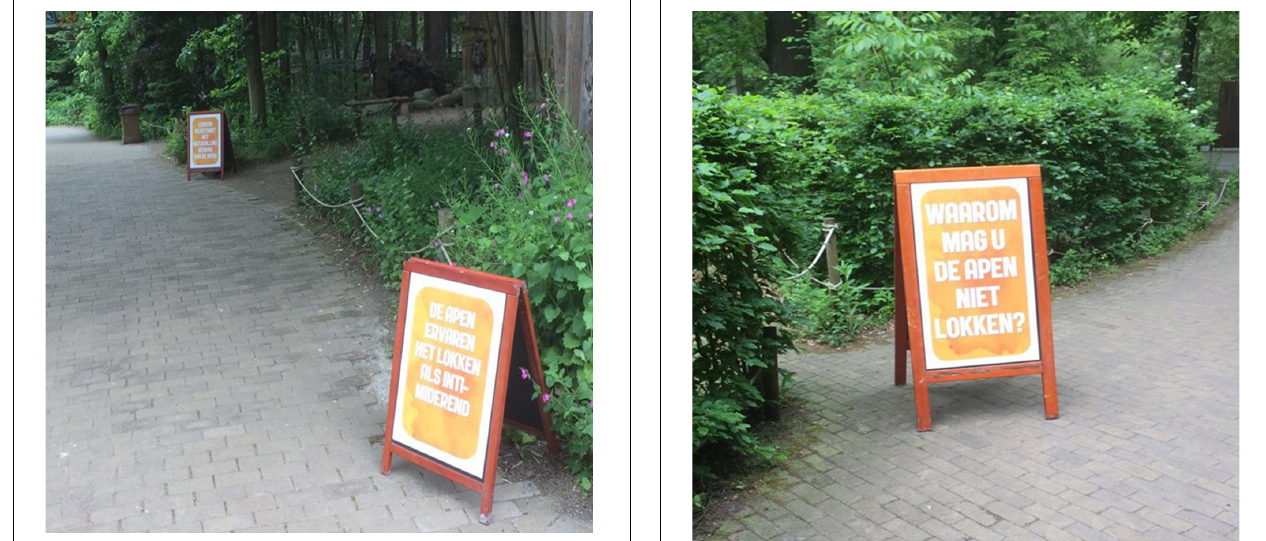
FIGURE 2 | Sign with question: “why should you not lure the